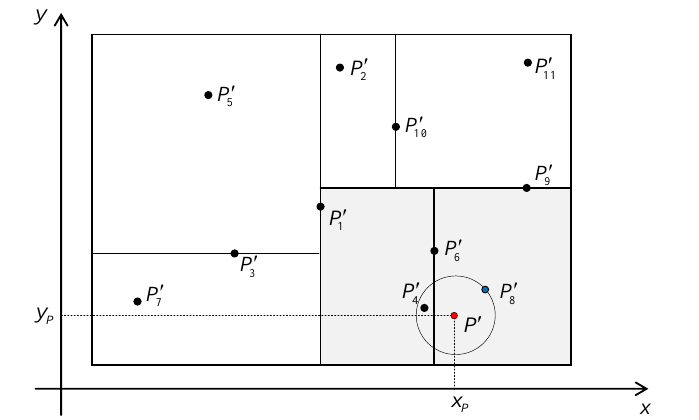
Figure 12. A graphic presentation of the final stage of the procedure while using the kd ‐ tree structure.